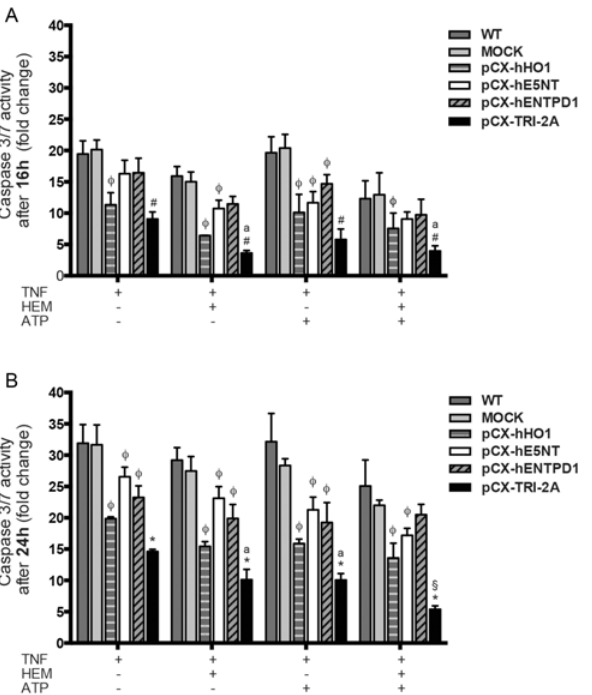
Fig 6. pCX-TRI-2A transfected-cells are protected against TNF- α -induced apoptosis. Caspase 3/7 activities were determined in all cell groups after 16h ( A ) or 24h ( B ) of incubation with 50 ng/ml TNF- α alone or in combination with 20 μ M hemin and/or 200 μ M ATP. Expression of the three human genes in TG cells significantly reduced the activation of effector caspases 3/7. The data are expressed as mean ± SD of three independent experiments. [#] indicates significant difference between pCX-TRI-2A and all the other groups, except for pCX-hHO1, within the same treatment (ANOVA, p < 0.05). [ * ] indicates significant difference between pCX-TRI-2A and all the other groups within the same treatment (ANOVA, p < 0.05); [ ϕ ] indicates a significant difference between single gene-transfected cells and WT/mock within the same treatment (ANOVA, p < 0.05); [a] indicates significant difference as compared to TNF- α treatment alone within the same cell type (ANOVA, p < 0.05); [§] indicates a significant difference as compared to all the other treatments within the same cell type (ANOVA, p <